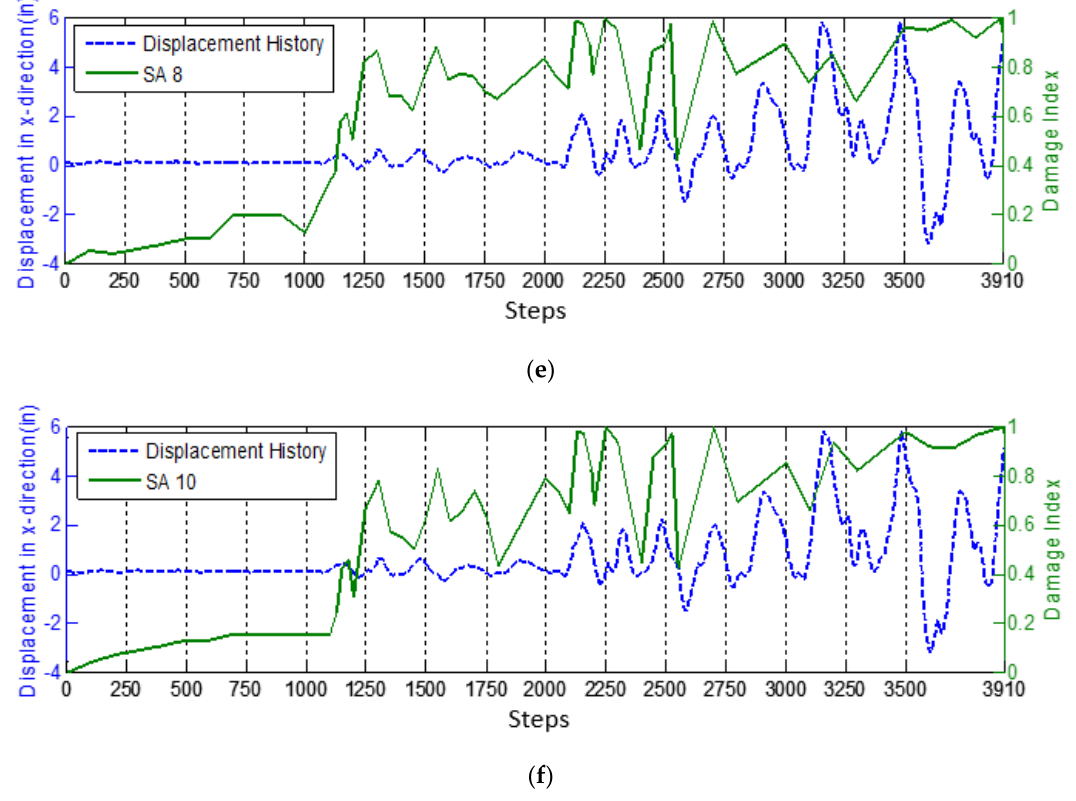
Figure 11. Overlap plots of damage indices and displacement history curves: ( a ) SA 3; ( b ) SA 4; ( c ) SA 5; ( d ) SA 7; ( e ) SA 8; ( f ) SA 10.